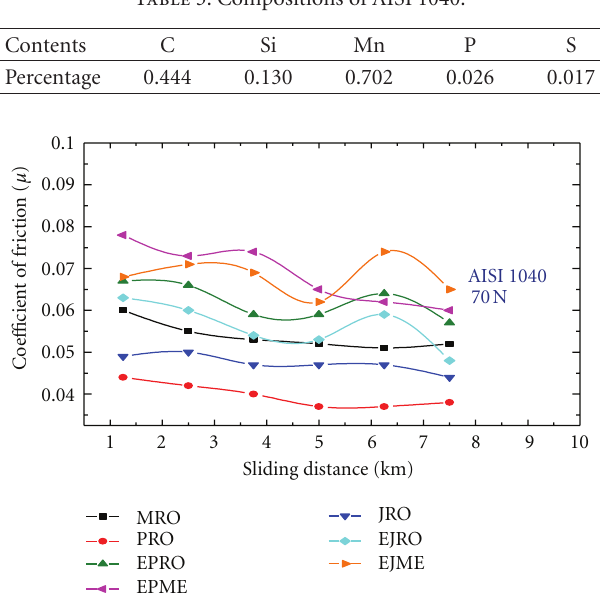
Figure 1: Variation of coe ffi cient of friction with sliding distance for 70 N.